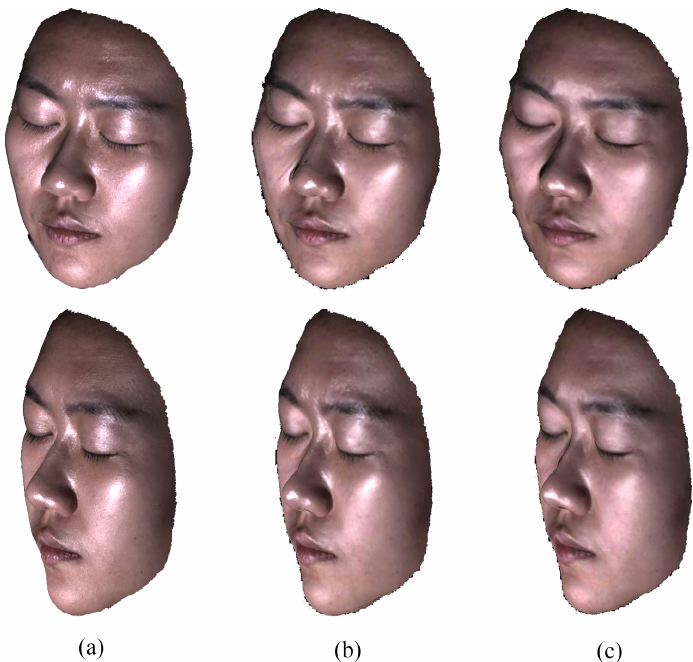
Figure 9. Experiment of synthesizing novel views. ( a ) Ground truth. ( b ) Synthesizing results using two input viewpoints. ( c ) Synthesizing results using eleven input